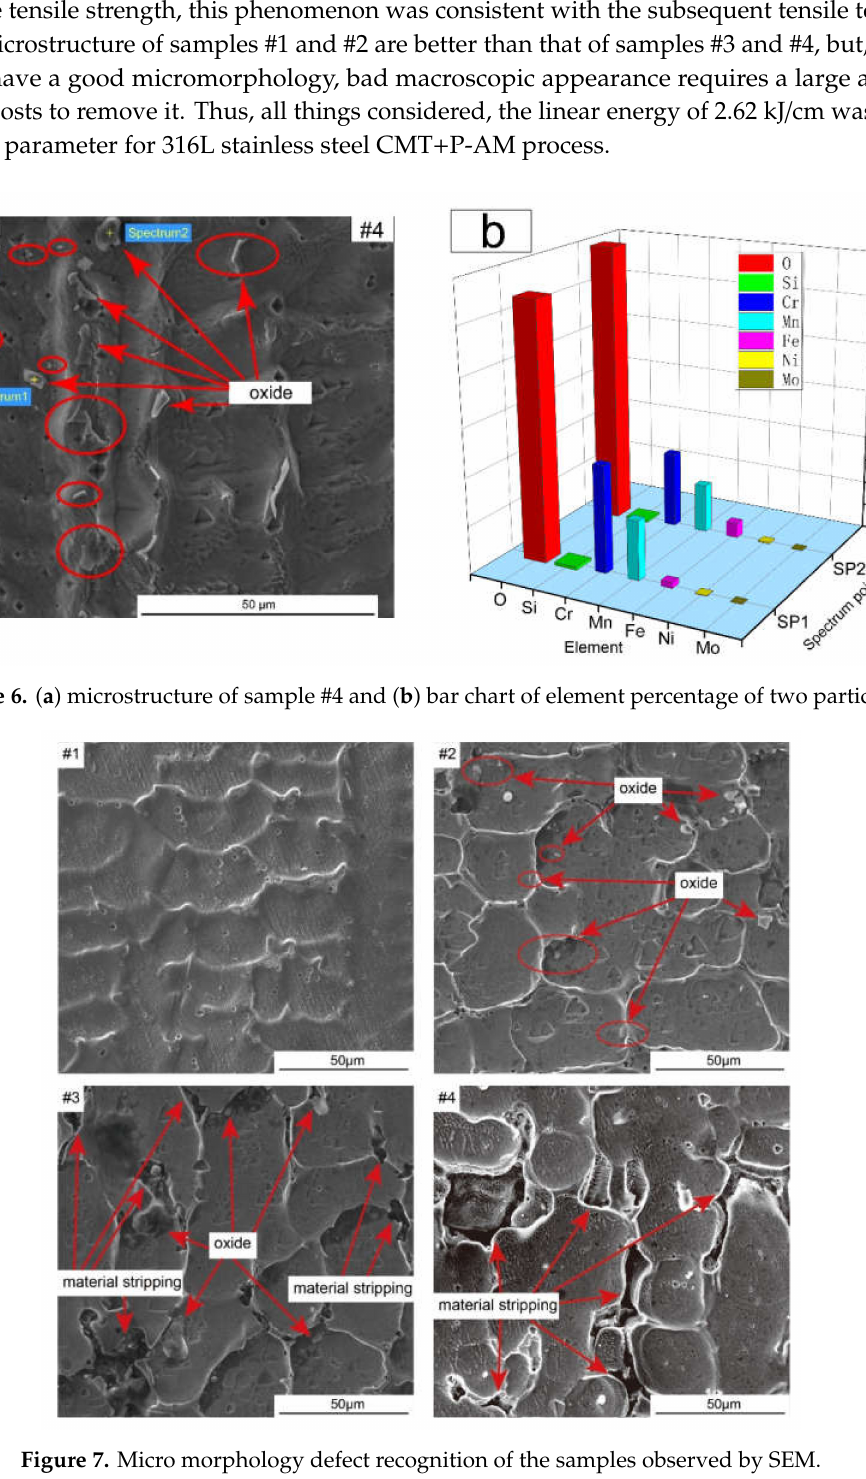
Figure 7. Micro morphology defect recognition of the samples observed by